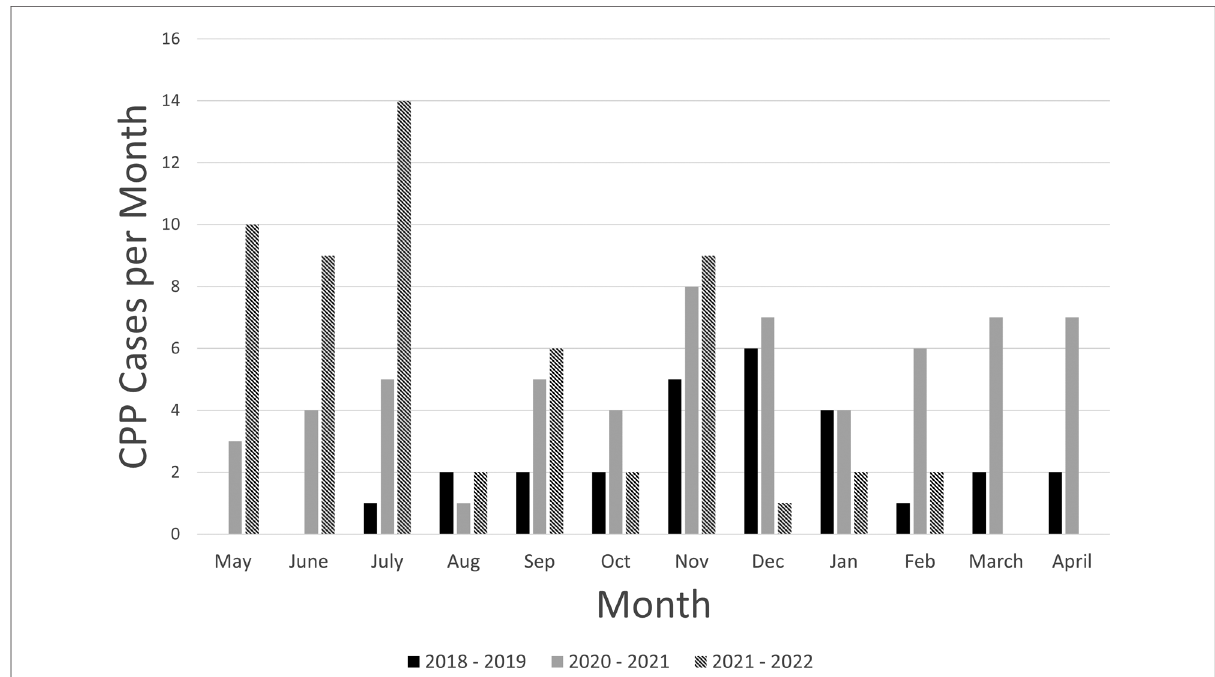
FIGURE 2 CPP cases by month of diagnosis, per year (from May to April of each year shown). Solid black bars represent pre-pandemic year, grey bars represent Covid-19 year, hatched bars represent the year after